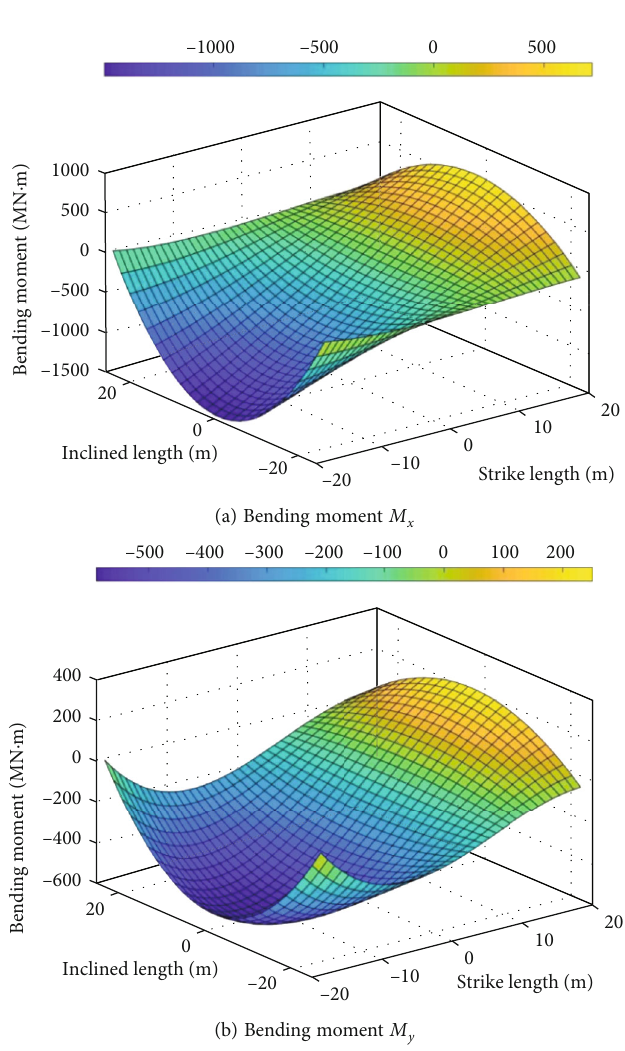
Figure 7: Bending moment of roof model with one side fi xed and three sides simply